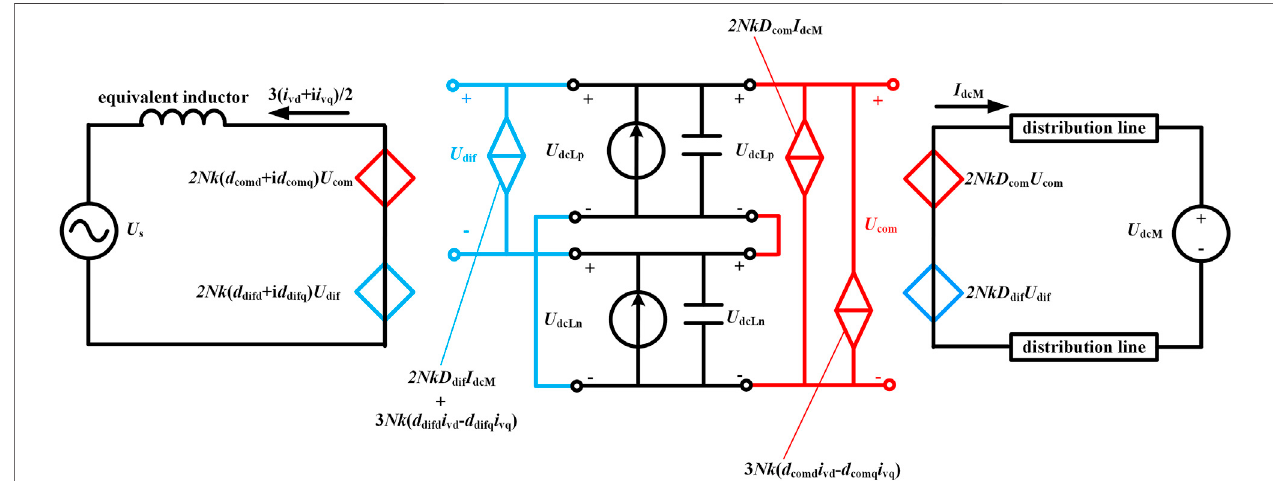
FIGURE 6 | Equivalent circuit of the virtual power fl ows on U com and U dif